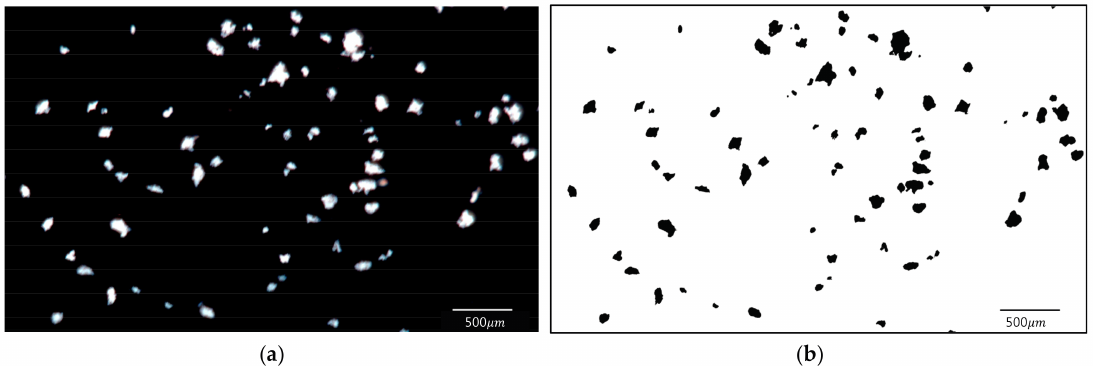
Figure 2. ( a ) A raw image; and ( b ) a processed image of a fixed floc sample on an agar